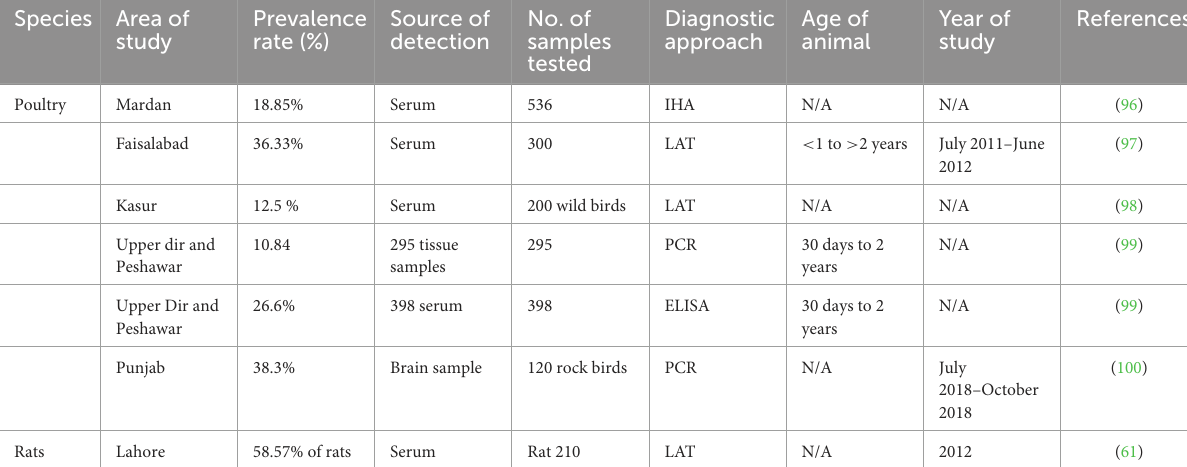
TABLE 6 Reported prevalence of Toxoplasma gondii in poultry and rats in Pakistan. Species Area of